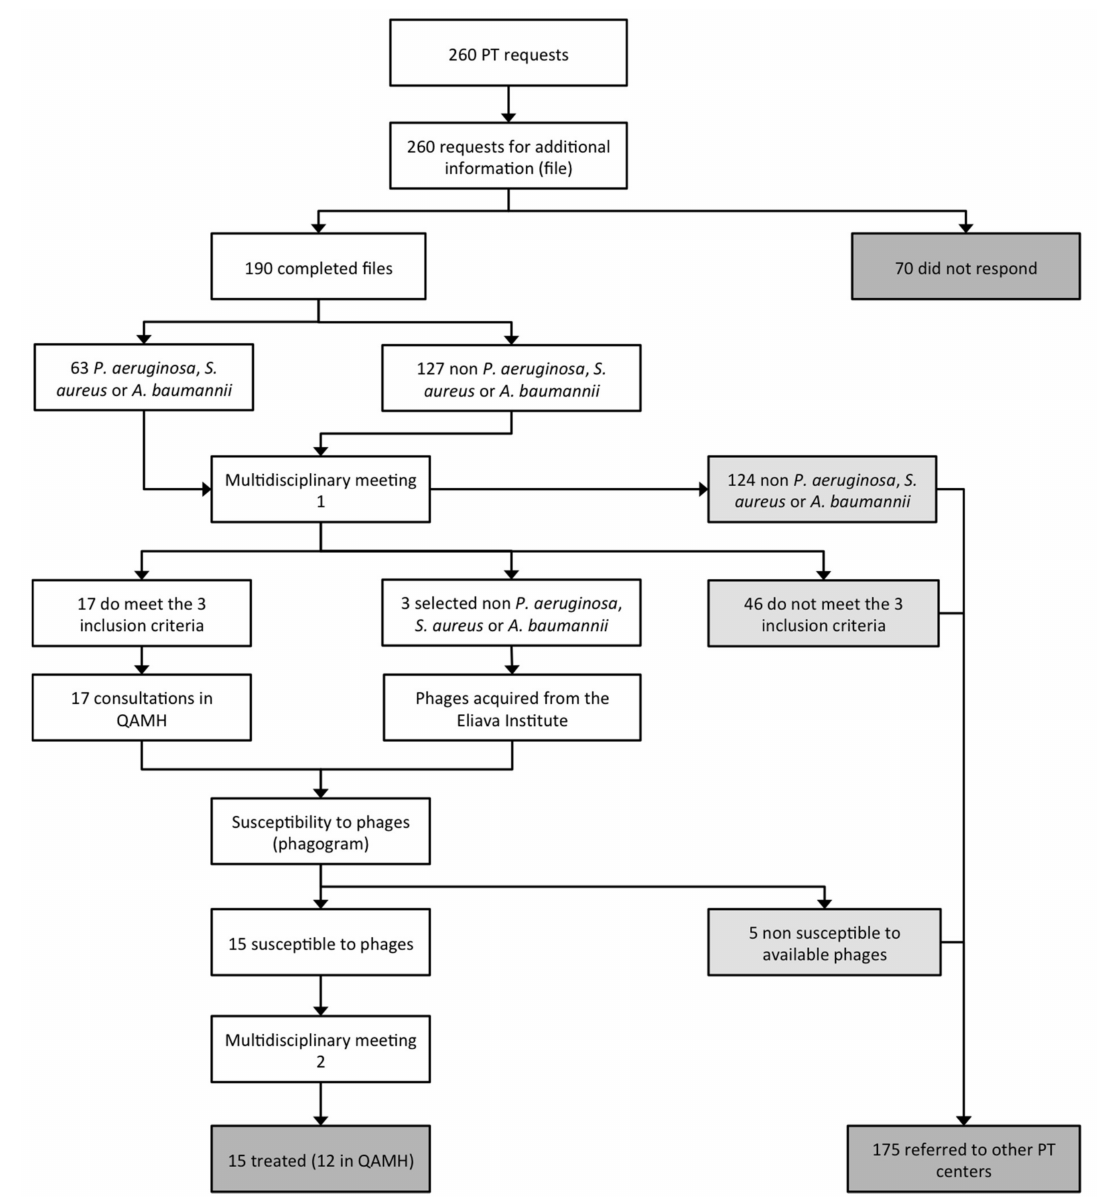
Figure 1. Patient care workflow in phage therapy at the Queen Astrid military hospital in Brussels (Belgium). PT, phage therapy; QAMH, Queen Astrid military